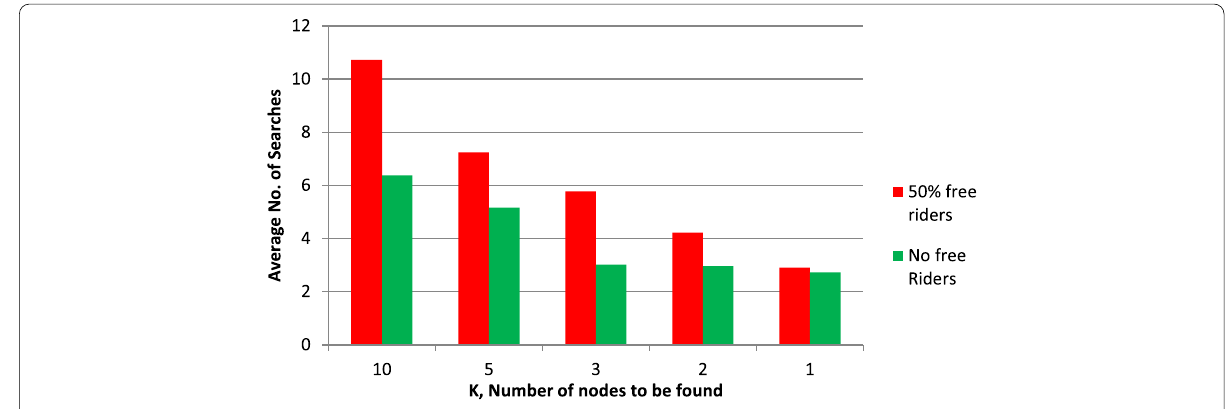
Fig. 4 Number of searches required to find k